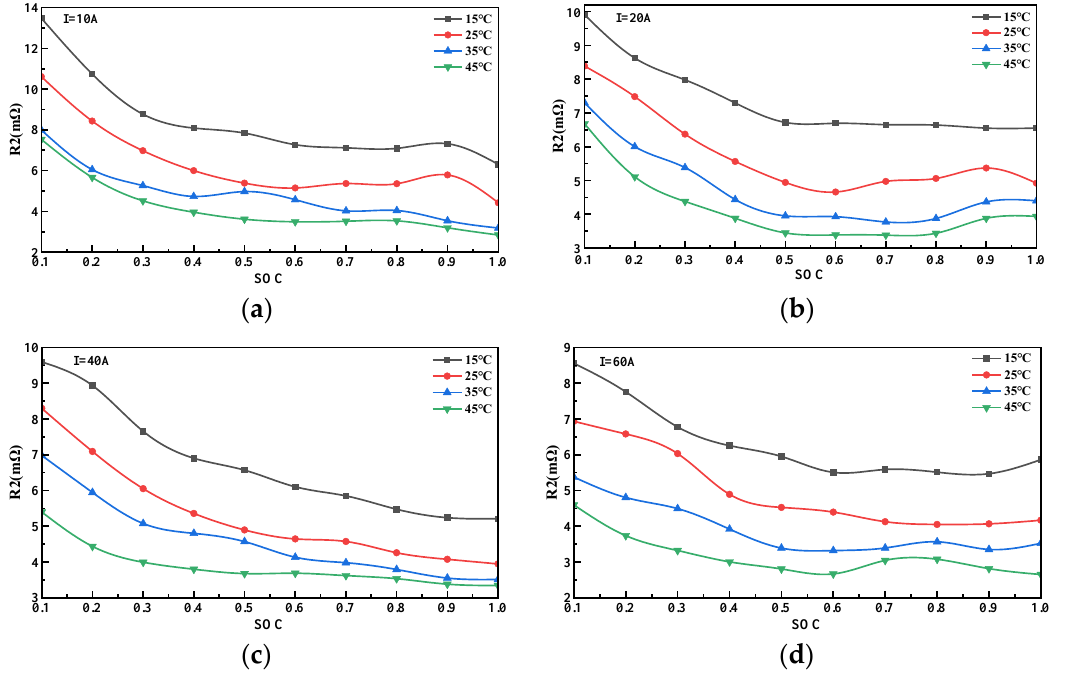
Figure 6. Identification of polarization resistance ( R 2 ) of battery: ( a ) The current of 10 A, ( b ) the